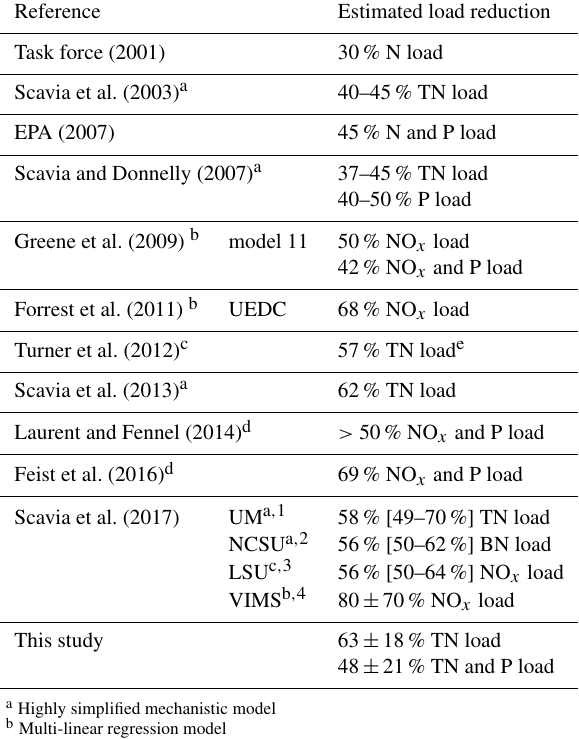
Table 2. Previously estimated nutrient load reductions necessary to reach the hypoxic area target of 5000km 2 and estimates from this study. In the right column, numbers in square brackets are 95% confidence intervals. Numbers that follow ± are SDs. TN refers to total nitrogen. P refers to phosphate. NO x refers to nitrate + nitrite. BN refers to bioavailable nitrogen as defined in the referenced